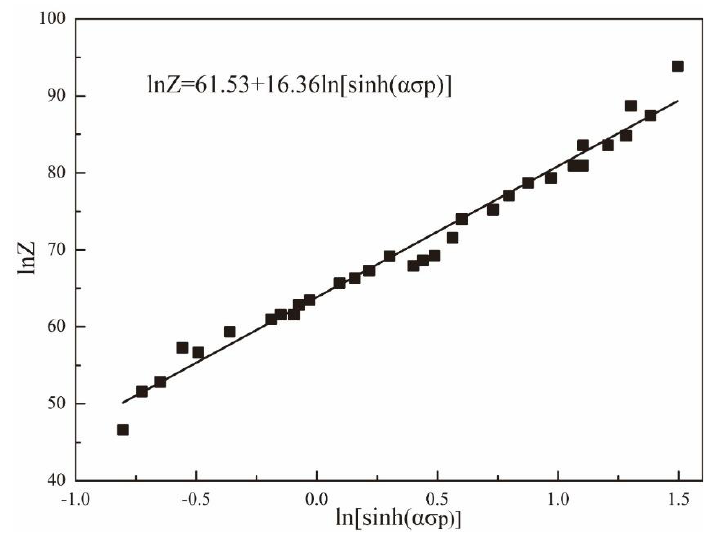
Figure 9. Relationship between ln [sinh (ασp)] and lnZ.